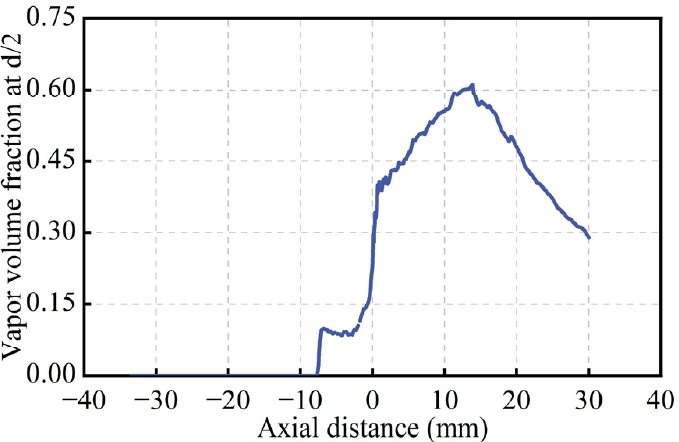
Figure 15. Axial vapor volume fraction distribution at d /2.